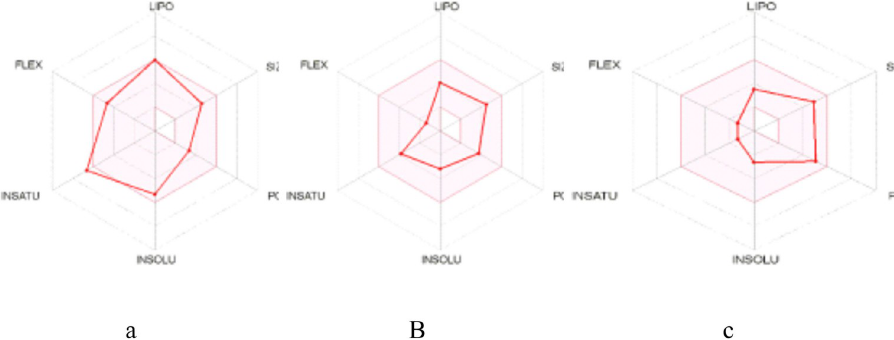
Fig 4. The bioavailability radars for reference and lead compounds (a) OOU (b) Isopteropodin (c) Strophanthidin.